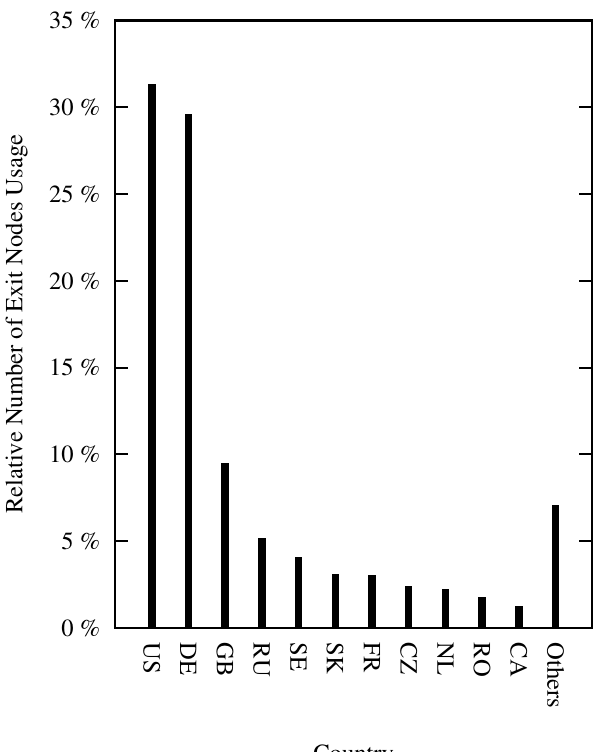
Figure 7. Exit Node